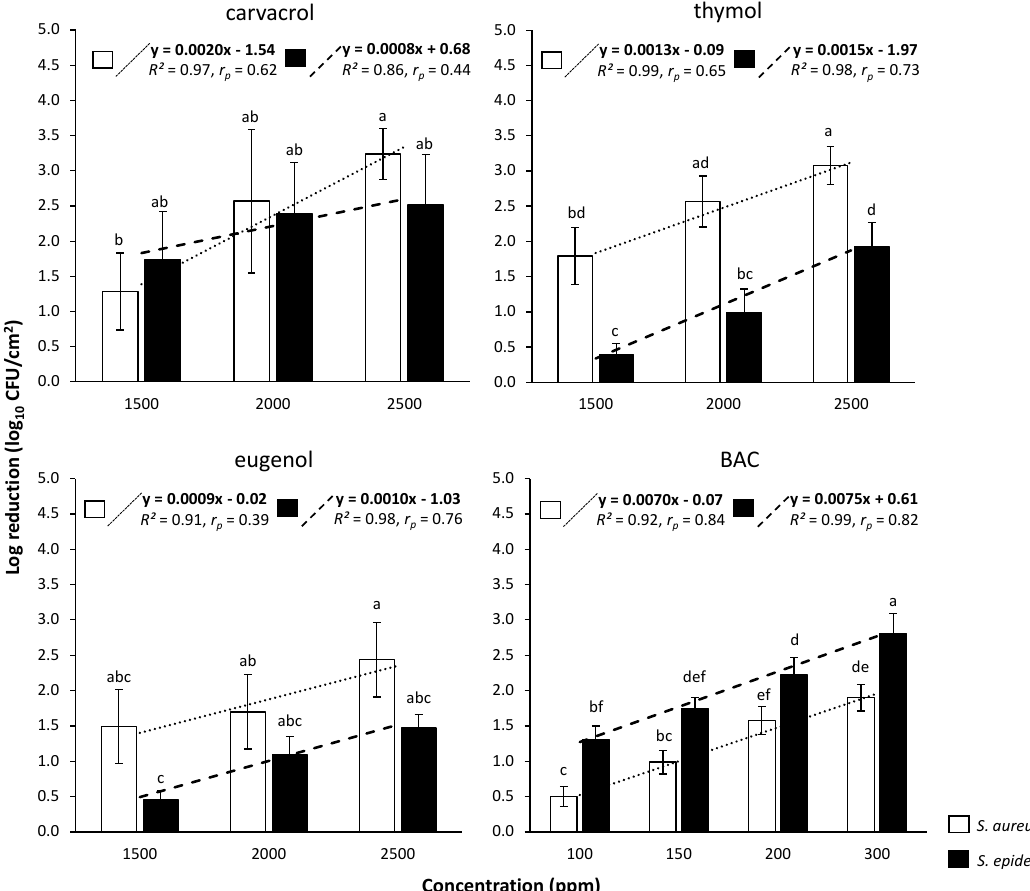
Figure 3. Log reductions (log 10 CFU / cm 2 ) of biofilm cells for each bacterial species ( (cid:3) S. aureus ; (cid:4) S. epidermidis ) following 6 min exposure to each compound (i.e., CAR, THY, EUG, and BAC) applied at different concentrations (ppm). The bars represent the mean values ± standard deviations. For each separate graph, mean values sharing at least one common letter shown above the bars are not significantly different ( p > 0.05). Dotted lines illustrate linear regression correlations between the log reductions achieved (for each species) at each tested compound’s concentration. The mathematical equations of these regression plots, together with their regression coefficients ( R 2 ) and Pearson’s correlation coefficients ( r p ) are also shown.